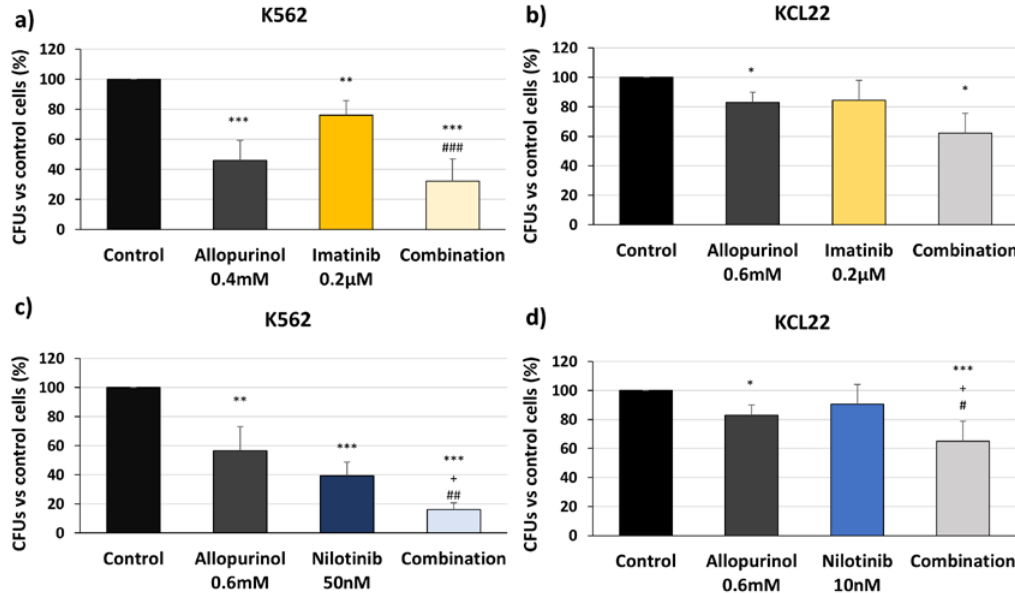
Figure 6. Allopurinol and TKI combination reduces the clonogenic capacity of the K562 and KCL22 cells. K562 and KCL22 cells were treated with TKIs (imatinib or nilotinib), allopurinol, or their combinations for 48 h. The clonogenic capacity after the treatments was analyzed in a semisolid medium by colony-forming unit (CFU) assays. ( a ) CFU number with respect to control in K562 treated with imatinib, allopurinol or their combination ( n = 5). ( b ) CFU number with respect to control in KCL22 treated with imatinib, allopurinol or their combination ( n = 4). ( c ) CFU number with respect to control in K562 treated with nilotinib, allopurinol or their combination ( n = 5). ( d ) CFU number with respect to control in KCL22 treated with nilotinib, allopurinol or their combination ( n = 4). Significant differences: *** p < 0.001, ** p < 0.01, * p < 0.05 with respect to control; + p < 0.05 with respect to allopurinol-treated cells; ## p < 0.01, # p < 0.05 with respect to TKIs-treated cells.